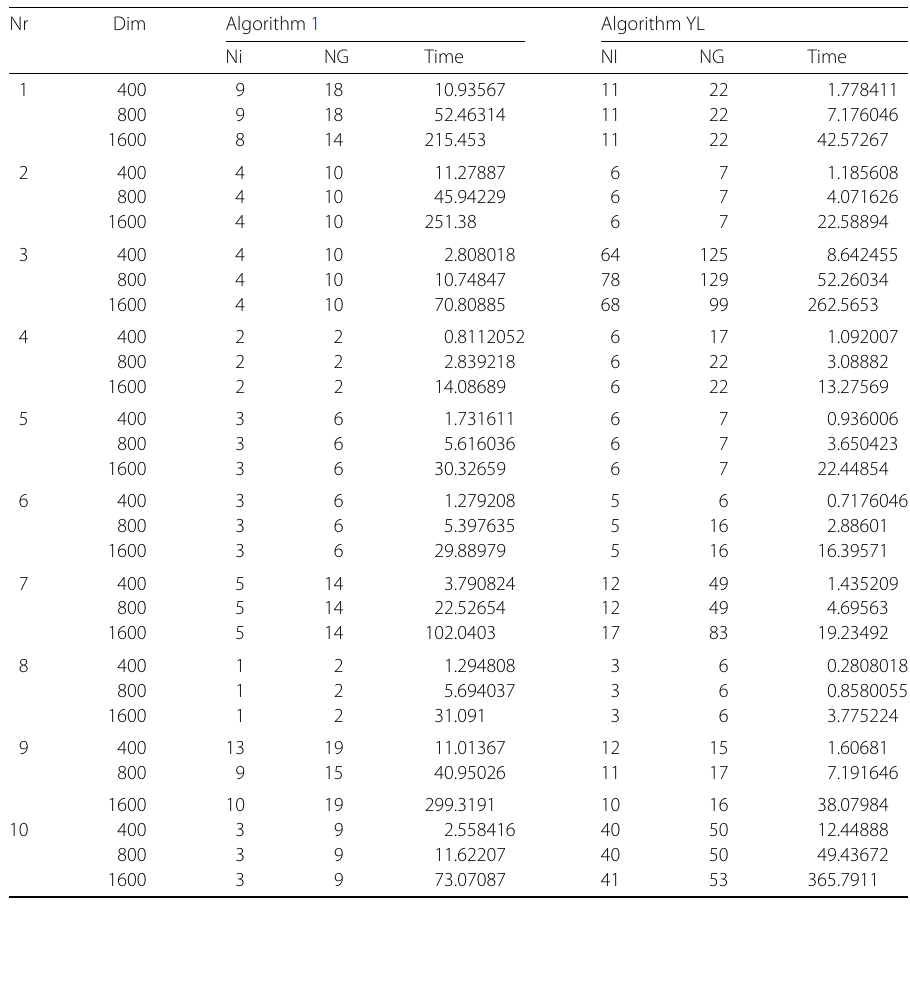
Table 1 Experiment results